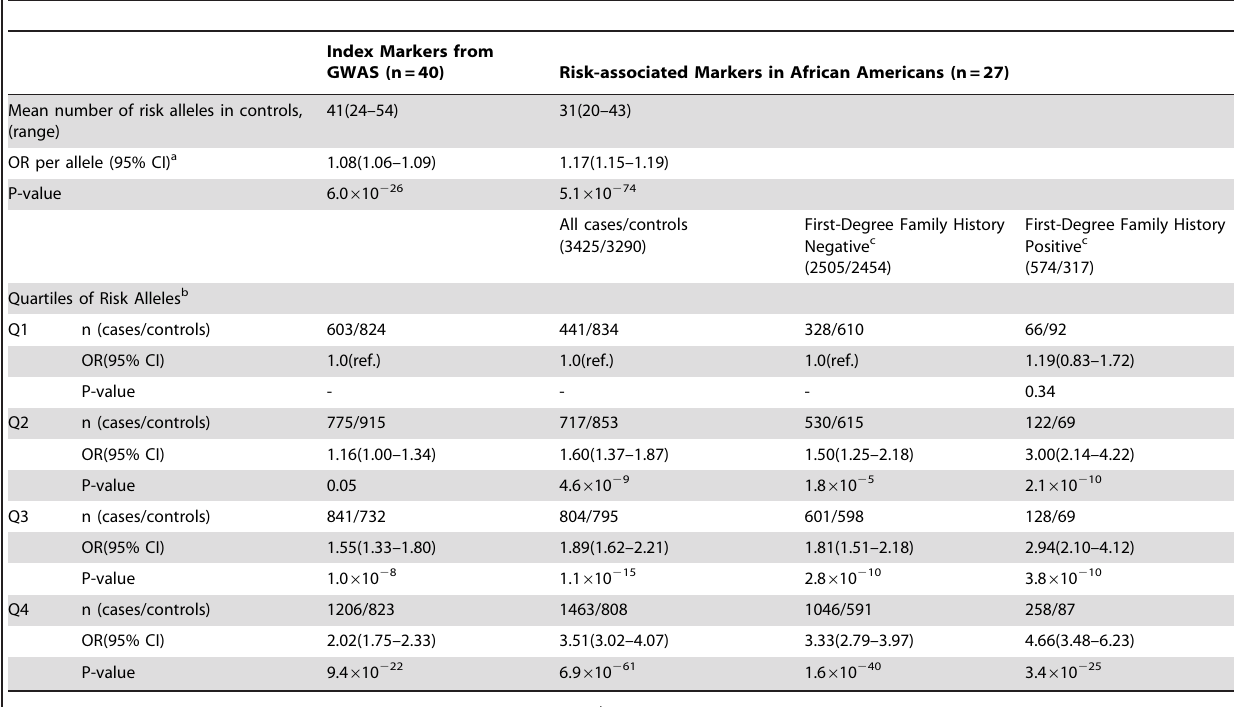
Table 3. The association of the total risk score with prostate cancer risk in African Americans.